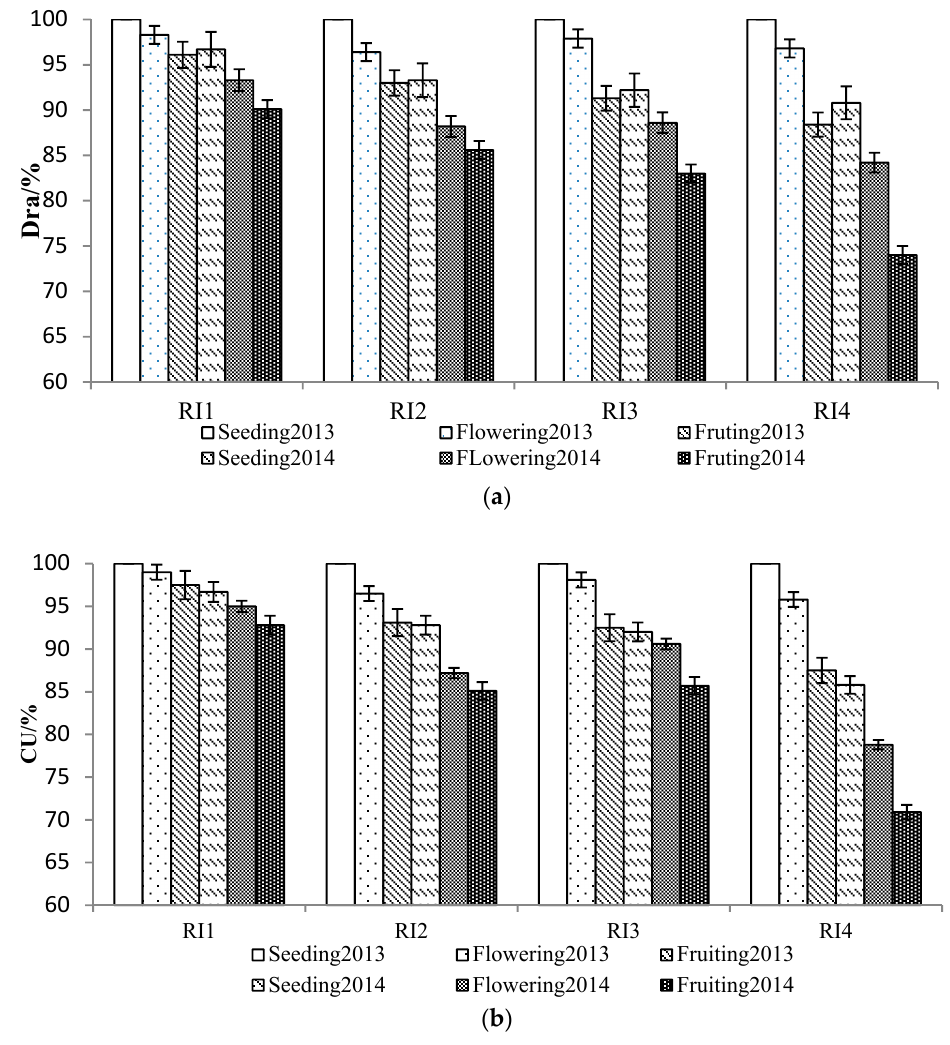
Figure 3. Discharge ratio variation (Dra) ( a ) and Christiansen coefficient of uniformity (CU) ( b ) variation under different fresh-saline alternating irrigation model. Table 3. T -test of Dra and CU under different fresh-saline alternating irrigation model.